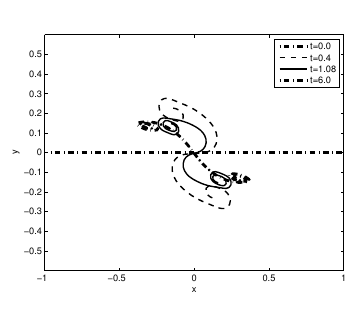
Figure 12. β ( l,t i ) with 5 jump in dependence on l for ωτ = 0 ⇒ 24, t f = 6.